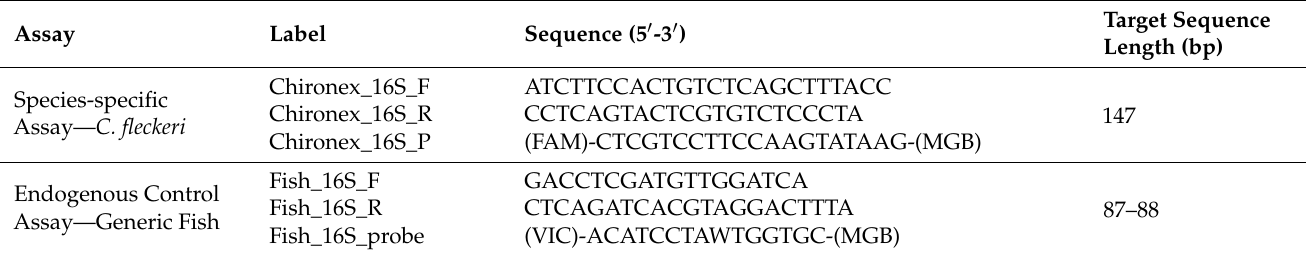
Table 2. Species-specific and endogenous control assays used to detect Chironex fleckeri and as technical